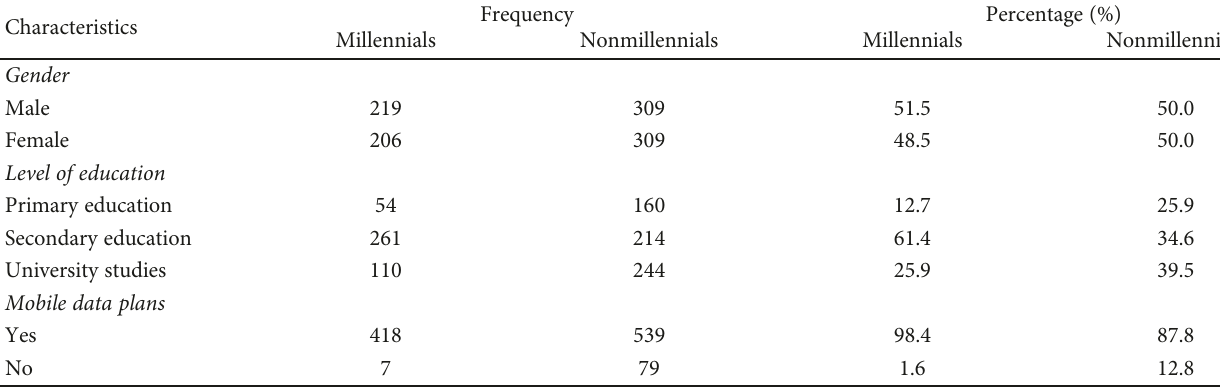
Table 1: Pro fi le of